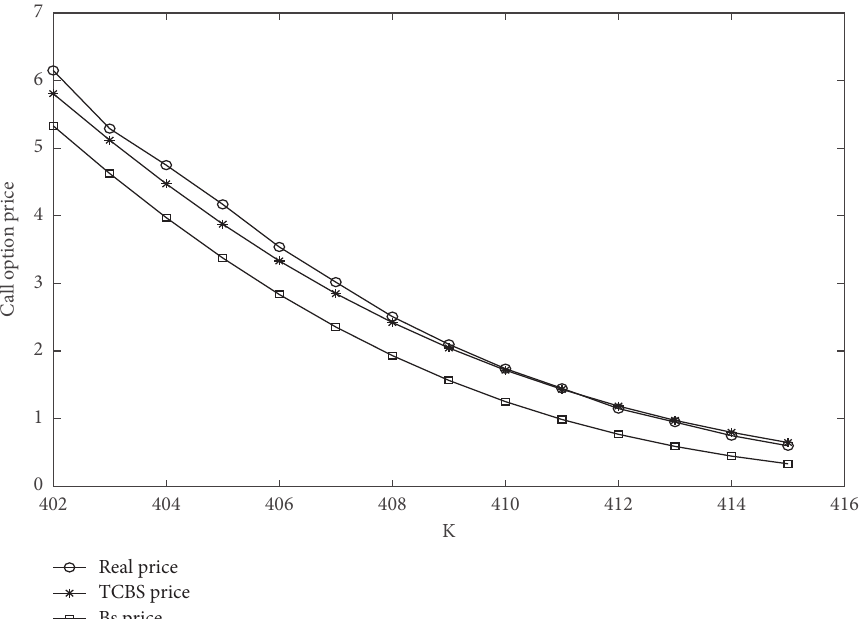
Figure 4: Comparison between the real Call option price with the one obtained by different models under different strike price K . Here, BS price stands for the price obtained by classical Black–Scholes model, and TCBS stands for the price obtained by equation (27) with time- changed Brownian